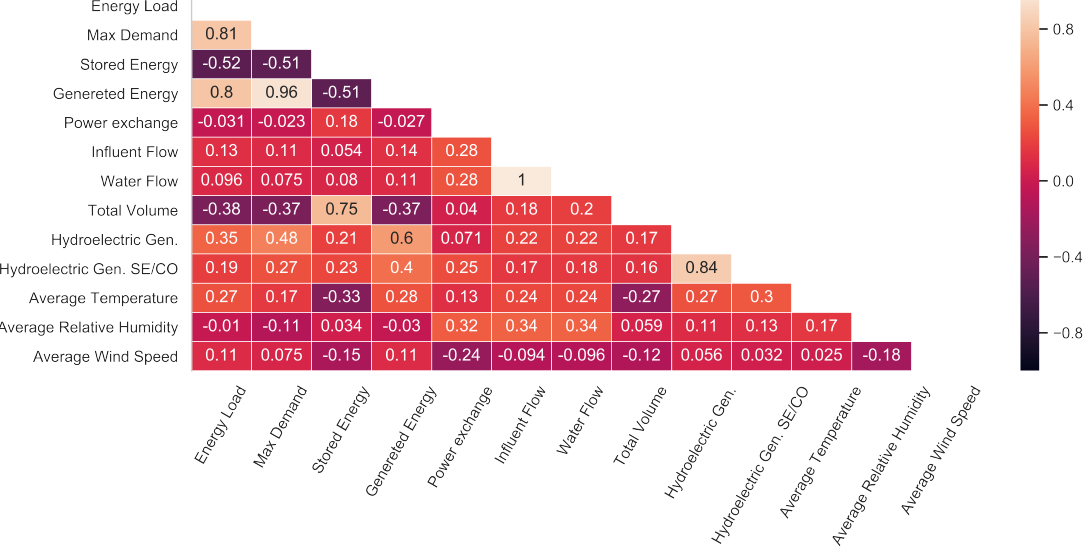
Figure 2. Pearson correlation, represented as a heat map for the original input